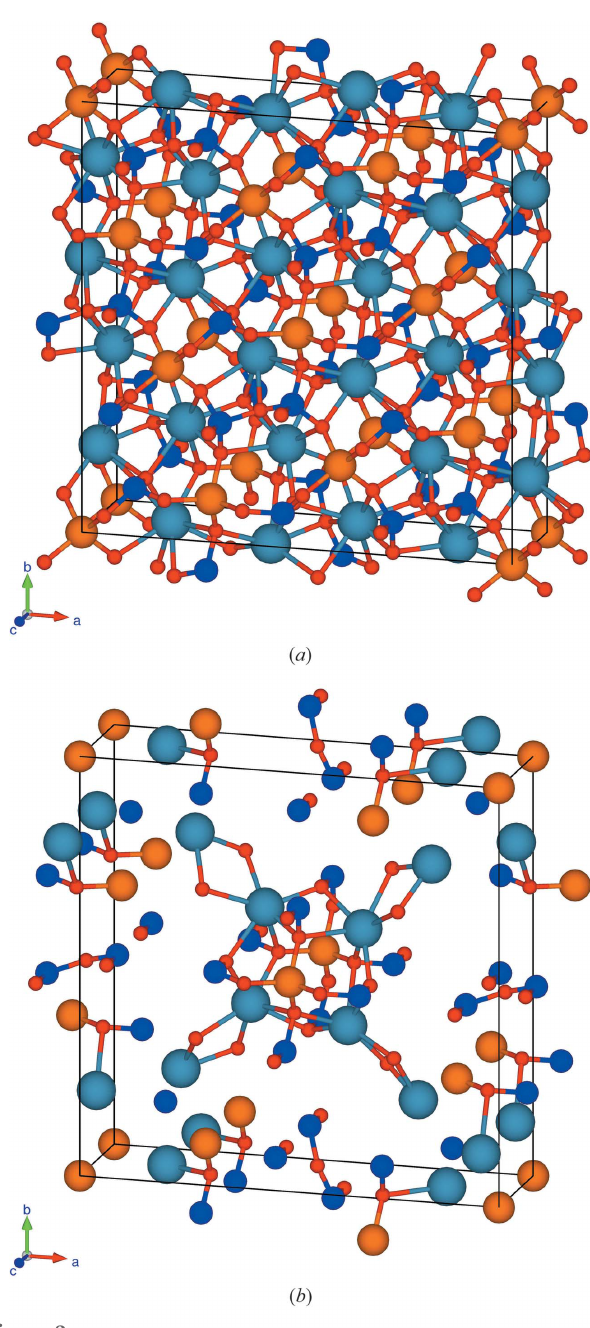
Figure 2 View of the unit cell of the twin lattice of melilite along to the (111) plane: ( a ) all atoms in the cell, ( b ) the quasi-restored